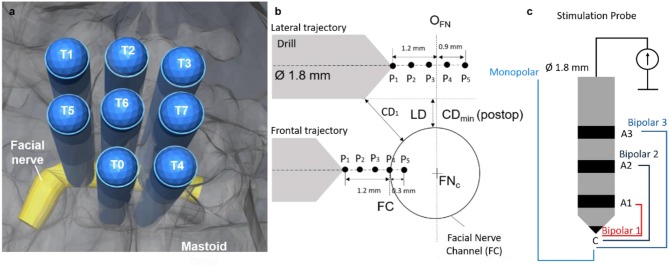
(a) Trajectories (n = 8) plan relative to the facial nerve. (b) Schematic representation: five measurement points planned relative to the origin of the facial nerve in the drill axis (OFN) for the lateral trajectories. Five measurement points planned relative to the facial nerve canal (FC) in the frontal trajectories. Lateral distance (LD) planned between 0.00 mm and 0.5 mm. Drill trajectory to nerve closest distance defined as CD. (c) Stimulation probe, same diameter as the drill, four different stimulation configurations, bipolar 1 (red), bipolar 2 (dark blue), bipolar 3 (blue) and monopolar (light blue). The monopolar configuration is measured with needle anode near the sternum.